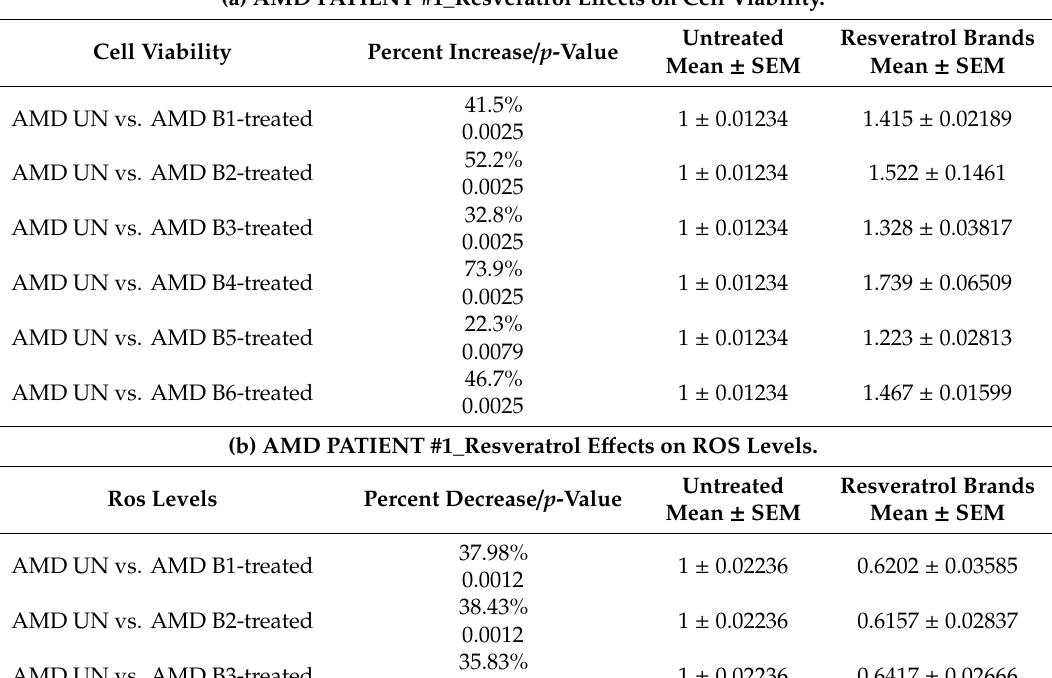
Table 3. E ff ects of resveratrol formulations on cell viability ( a ) and ROS levels ( b ) in AMD patient #